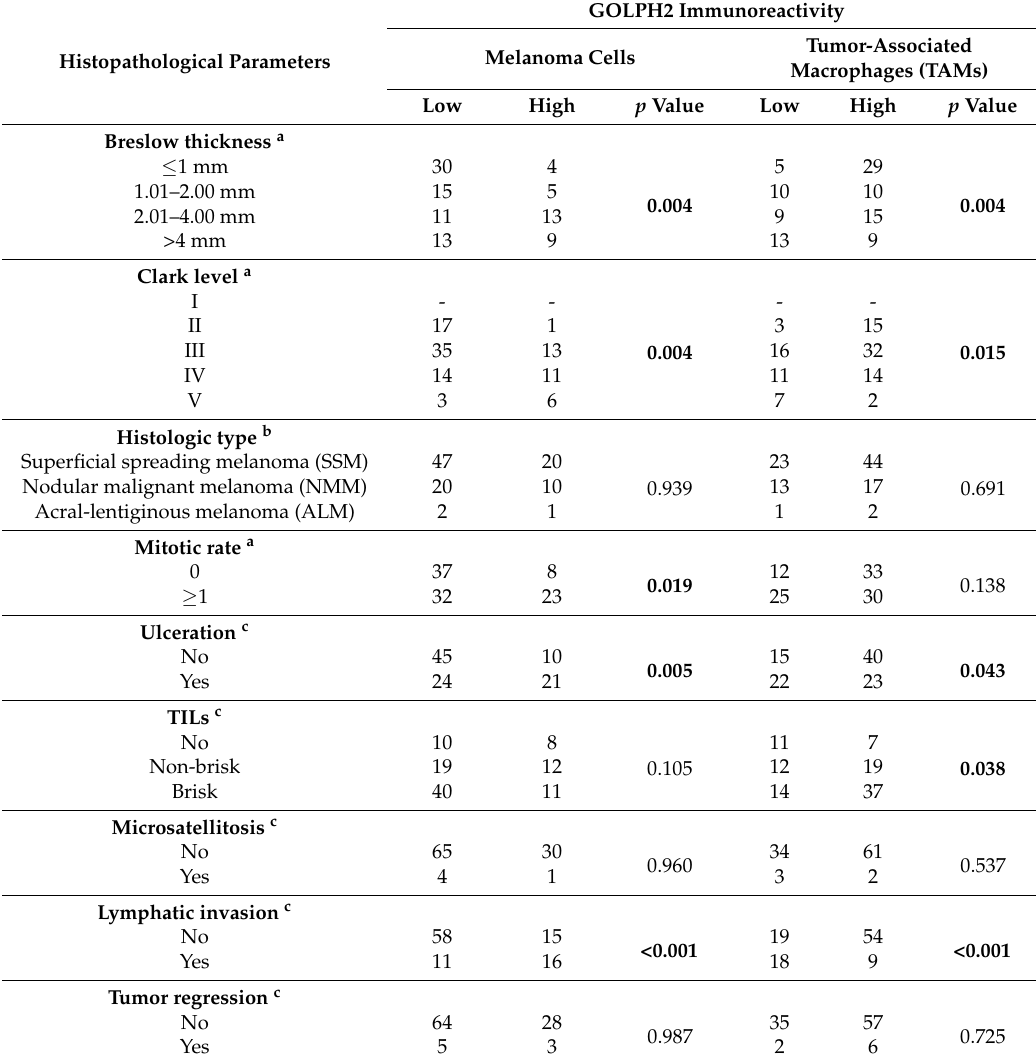
Table 2. Correlations between GOLPH2 immunoreactivity in melanoma cells and tumor-associated macrophages, and pathological